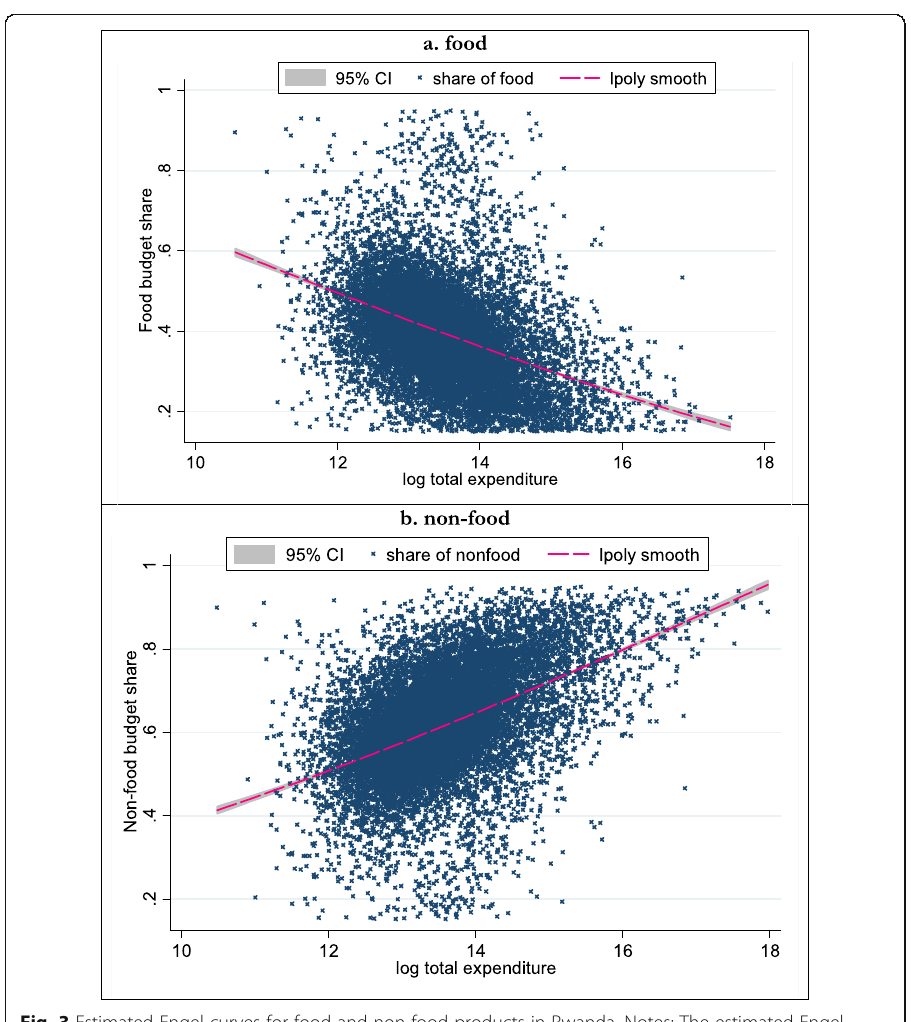
Fig. 3 Estimated Engel curves for food and non-food products in Rwanda. Notes: The estimated Engel curves have been obtained using a nonparametric approach based on the use of local quadratic polynomials. 95% CI, 95% confidence interval; “ lpoly smooth ” , smooth localized